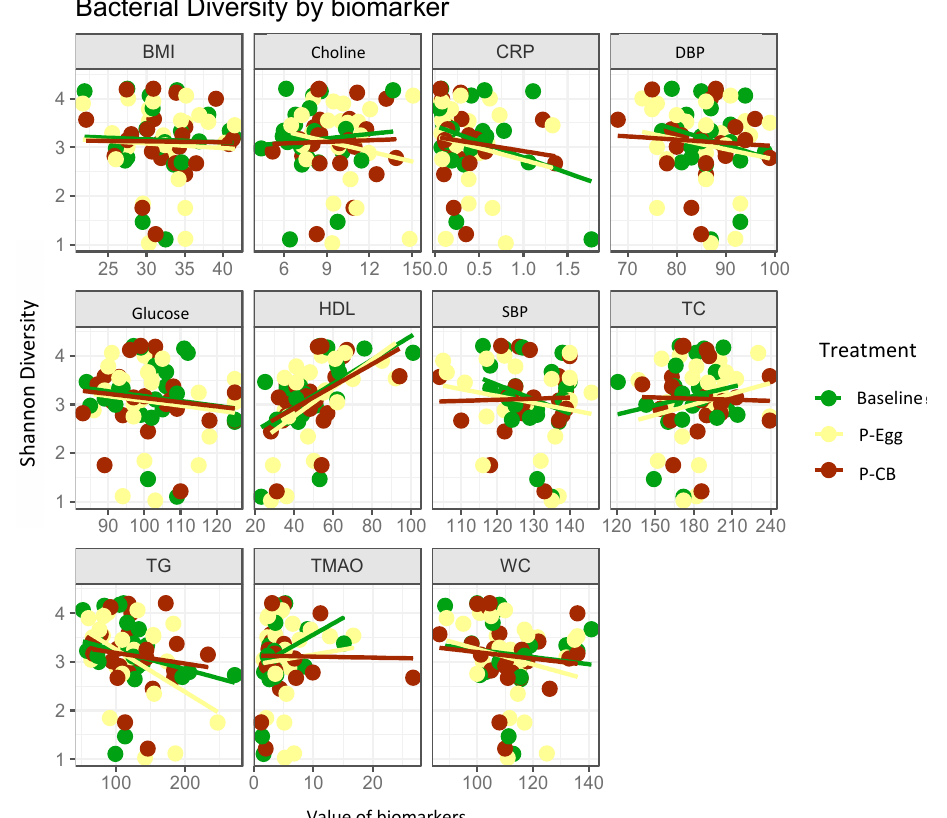
Figure 5. Correlations between plasma biomarkers and bacterial diversity based on treatments. BMI = body mass index, CRP = C reactive protein; DBP = diastolic blood pressure; HDL = high density lipoprotein; SBP = systolic blodd pressure; TG = triglycerides, TC = total cholesterol; TMAO = trimethylamince oxid; WC = waist circumference at baseline and after consumption of 3 eggs/d (Egg) or choline bitartrate (Choline) supplementation for 4 weeks. Only the correlation between bacteria diversity and plasma HDL cholesterol was found to be significant (r = 0.79, p <